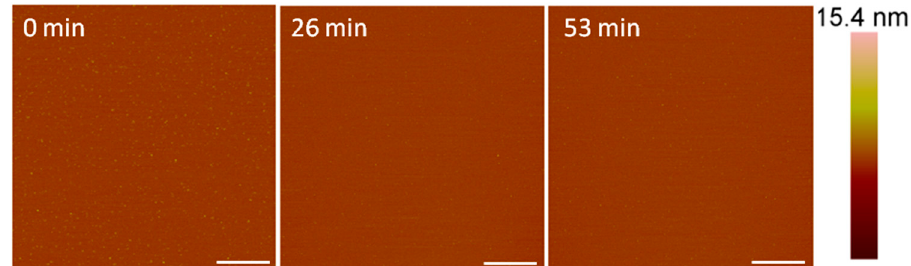
Figure 2. Representative AFM (height) images of a supported PC membrane after exposure to 1 µM alamethicin, with z scale bar shown on the far right. The stable lipid membrane before peptide injection is shown at t = 0 min. The scale bars represent 1 µm.